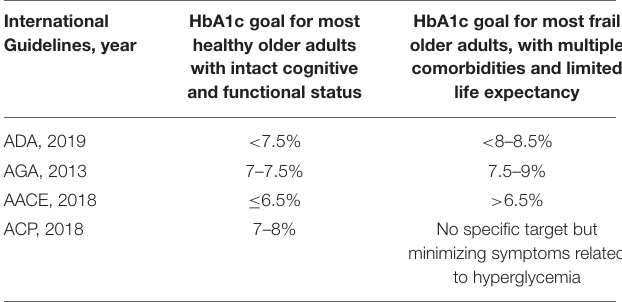
TABLE 1 | Glycemic targets in elderly patients according to the current international